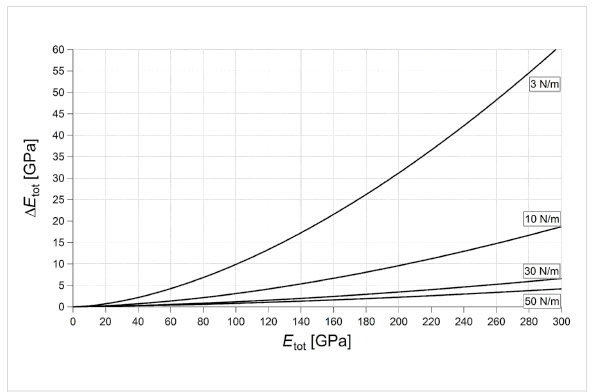
Figure 3: Error Δ E tot engendered by an uncertainty Δ f n / f n 0 = 1%, calculated from Equation 20 with γ = 0.97, F = 100 nN, R = 30 nm, and four values of k c (3, 10, 30, and 50 N/m), as indicated by the